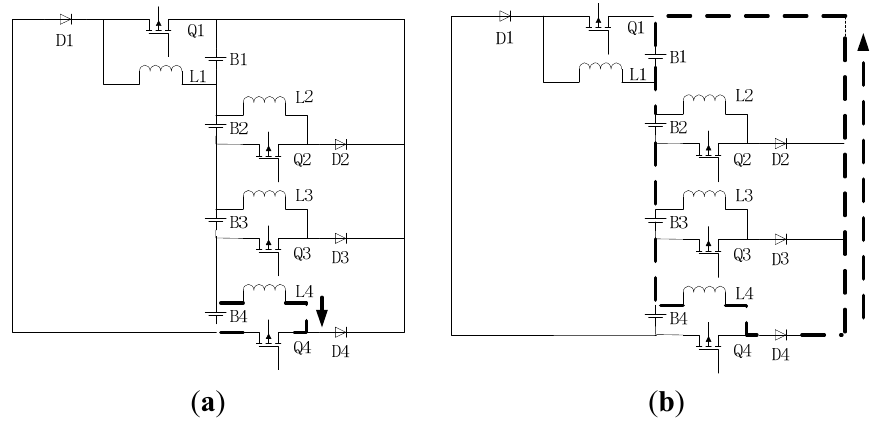
Figure 6. Current path from B from B